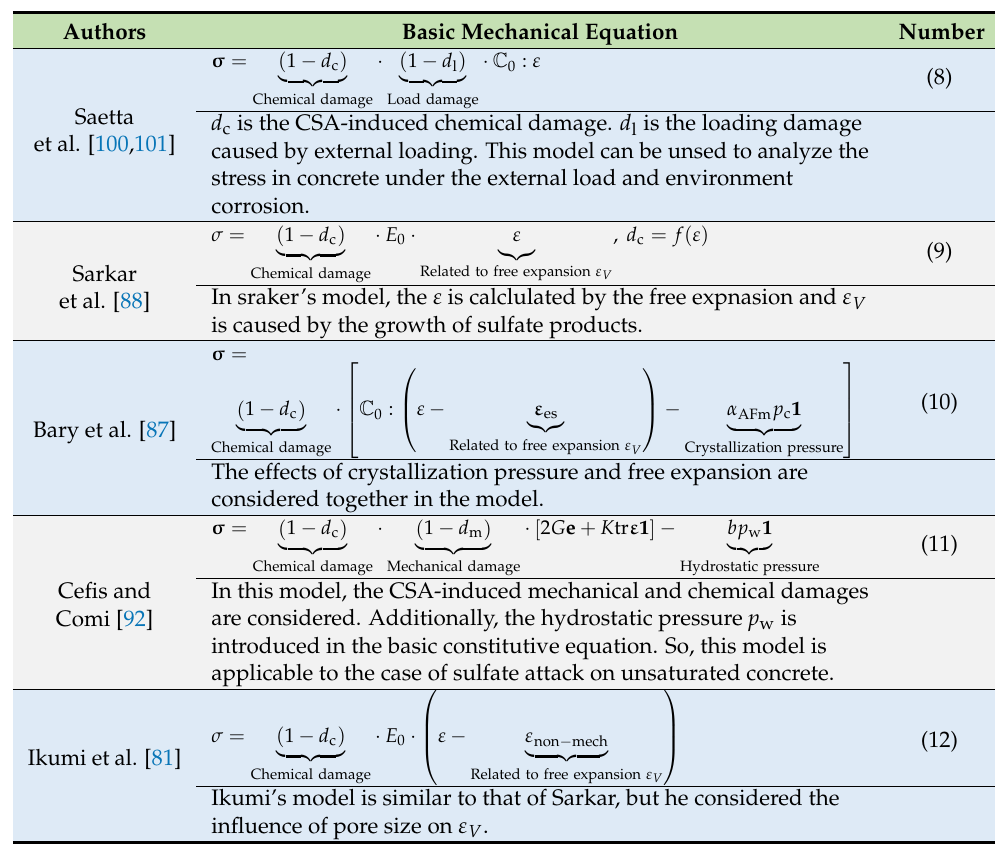
Table 6. Basic constitutive equations in the chemo-mechanical